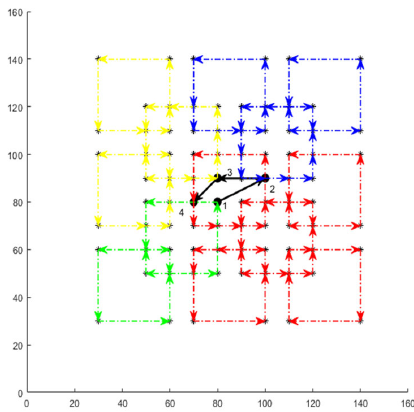
Figure 6. The obtained running path of the print head (1, 2, 3, and 4 represent the head-up point and running sequence of the nozzle).